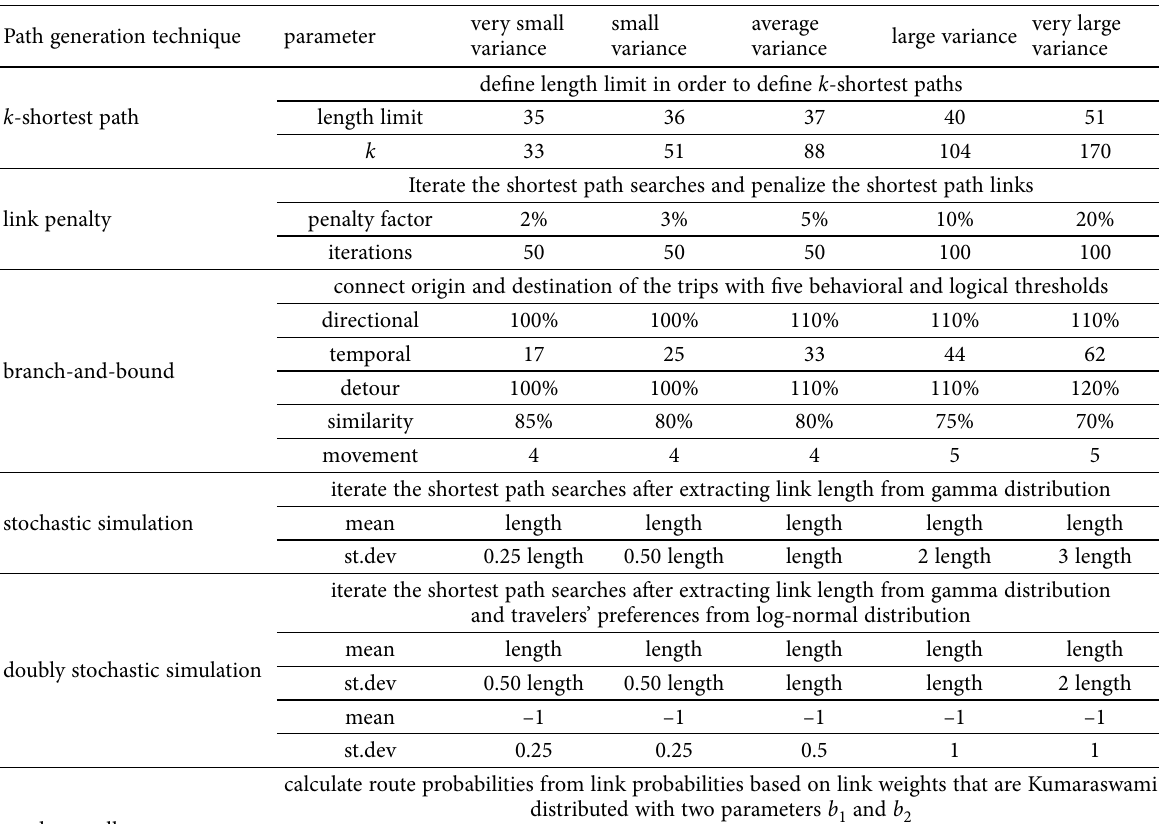
Table 1. Implementation of path generation